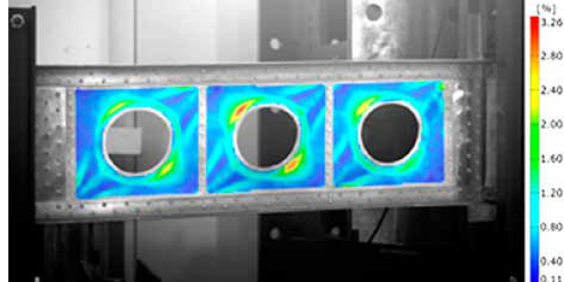
Fig. 11. Major strain (beam 1C, T > T cr